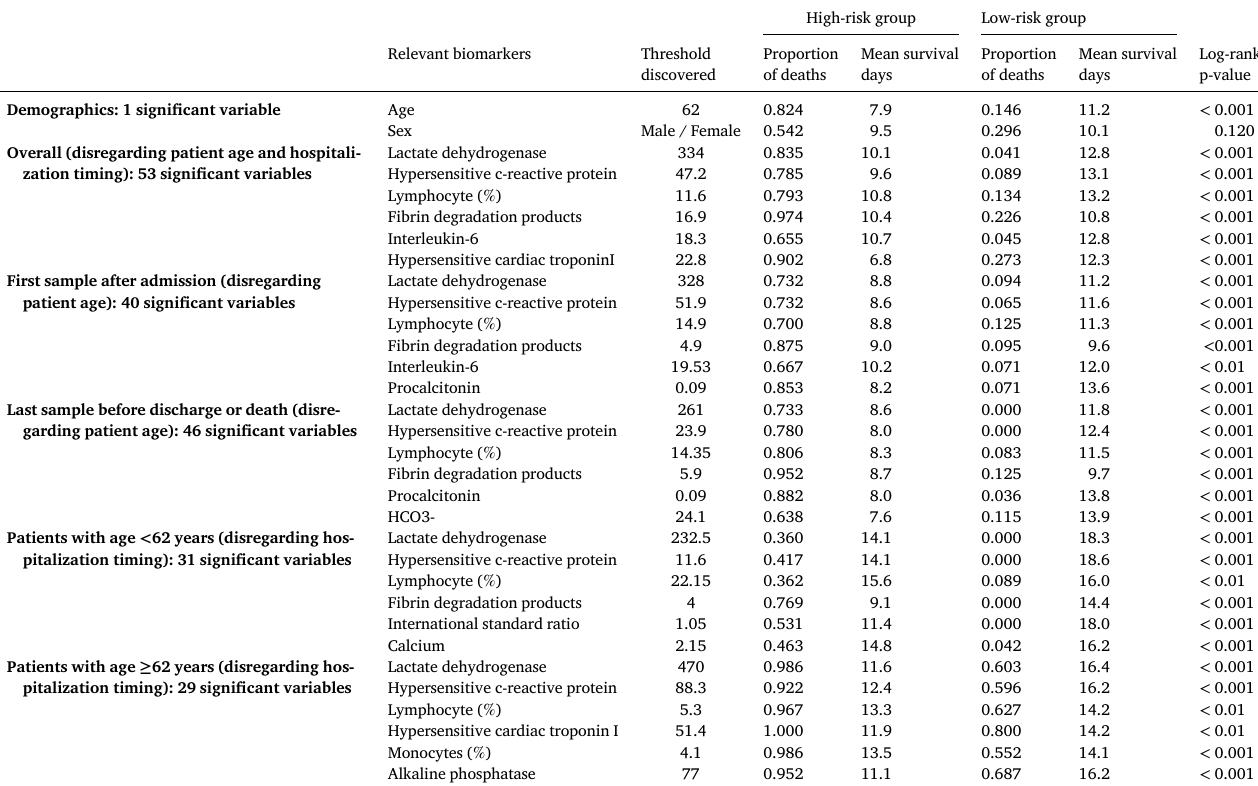
Fig. 1. Kaplan-Meier curves of the clinical biomarkers of (a) age, (b) Lactic Dehydrogenase (LDH), (c) high-sensitivity C-Reactive Protein (hs-CRP), (d) LDH combined with hs-CRP. Table 1 Discovered biomarkers according to the patient age and hospitalization